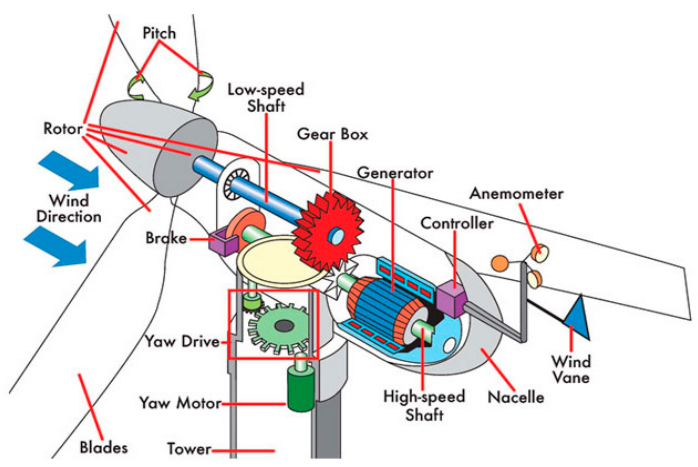
Figure 1. Components in a wind energy conversion systems [26].